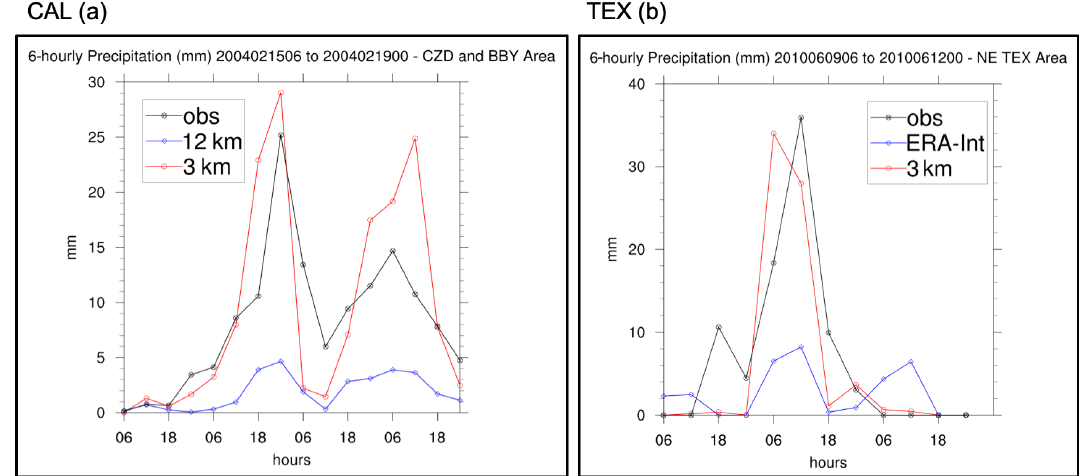
Figure 6. Time series of the 6-hourly accumulated precipitation (in mm on the y axis) during the CAL event (a) and during the TEX event (b) . The blue lines show RegCM4 12km and ERA interim 6-hourly accumulated precipitation averaged over the areas indicated by the black squares in Figs. 5 and 7, while the red line shows the 6-hourly accumulated precipitation simulated by RegCM4-NH. The observations are shown with a black